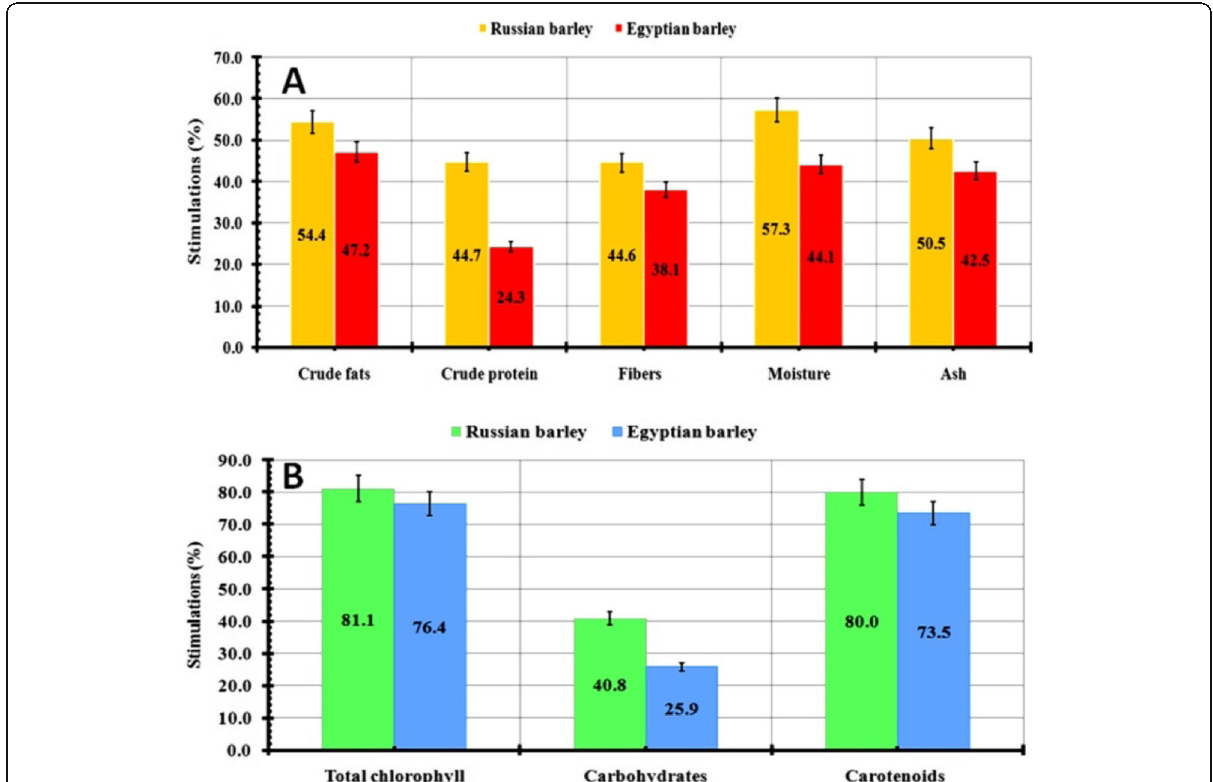
Fig. 7 Biochemical metabolites of the sprouting barley plant that treated with endophytic T .harzianum through hydroponic system; ( A ): Crude fats, crude protein, fibers, moisture, ash; ( B ): Total chlorophyll, carbohydrates,